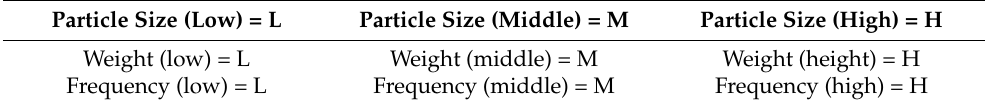
Table 2. Fuzzy sets of the fuzzy controller.